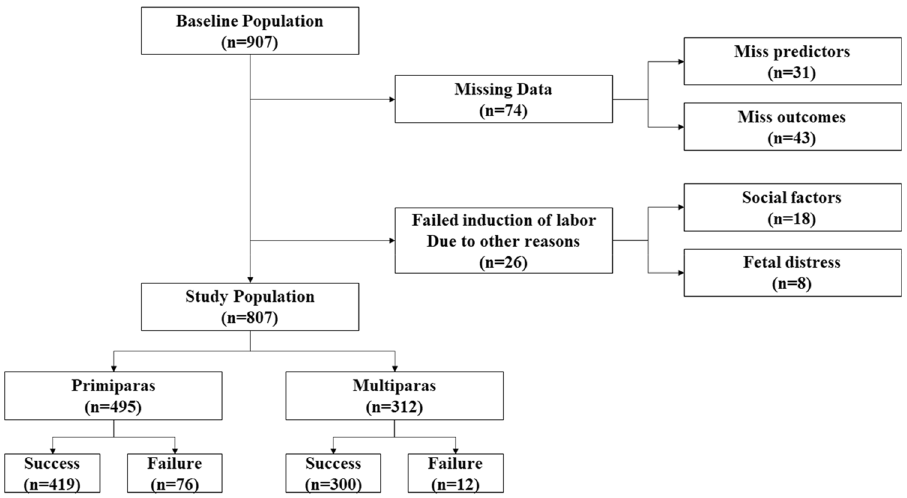
Figure 1. A flow chart for study population